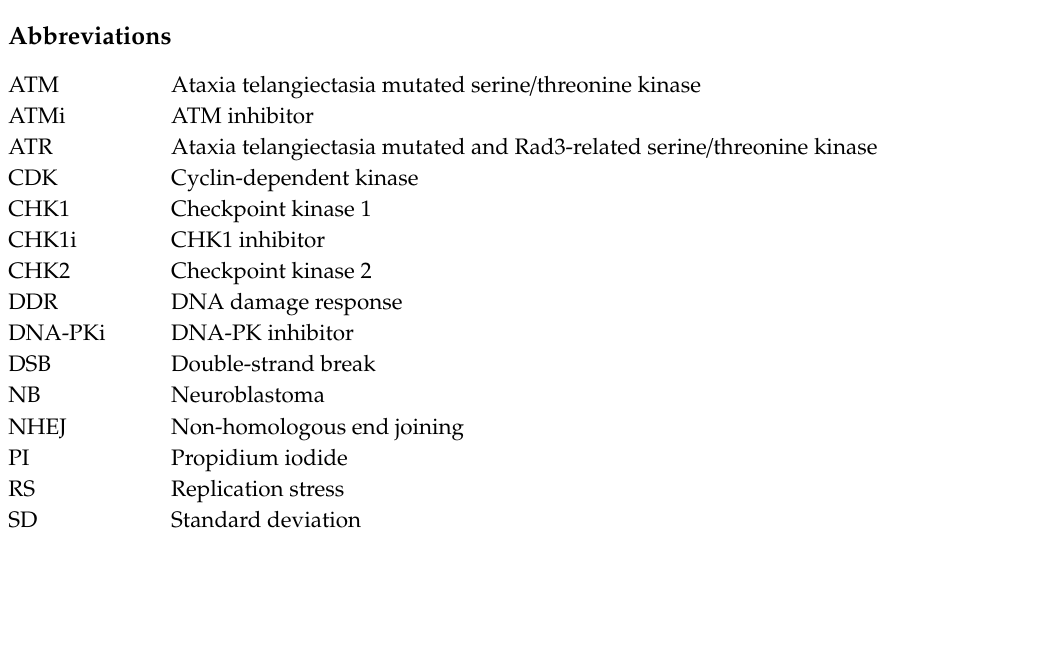
Figure 6. Blockade of the DDR enhances the therapeutic efficacy of CHK1i in MYCN-amplified NB Figure S1: Expression of CHK1 correlates with an unfavorable prognosis and with MYCN expression in NB patients, Figure S2: IC 50 of PF-477736 in CHK1i low- or high-sensitive NB cell lines, Figure S3: Di ff erential cells. response between CHK1i -sensitive (SMS-SAN) and -insensitive (NB-39-nu) NB cell lines, Figure S4: 1–10 µ M PF-477736 inhibited cell growth in NB-39-nu cells, Figure S5: Combination treatment with CHK1i (PF-477736) and ATMi (Ku55933) increases the proportion of NB cells in sub-G1 and